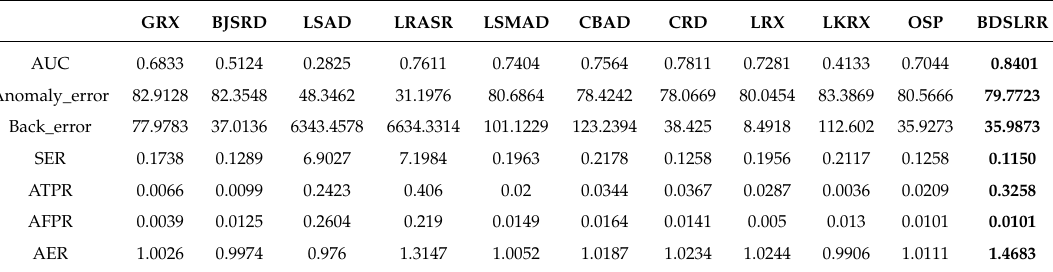
Table 5. Blind Test Dataset: Assessment Metric